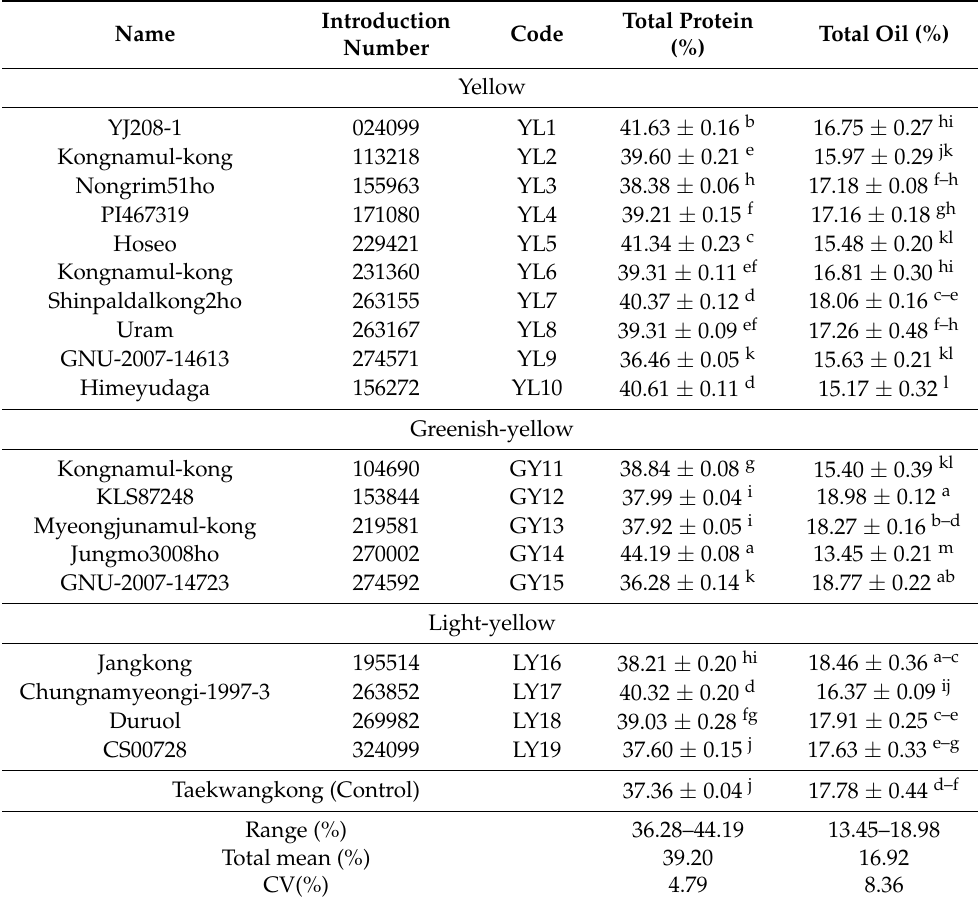
Table 1. Total protein and total oil contents in seeds of individual